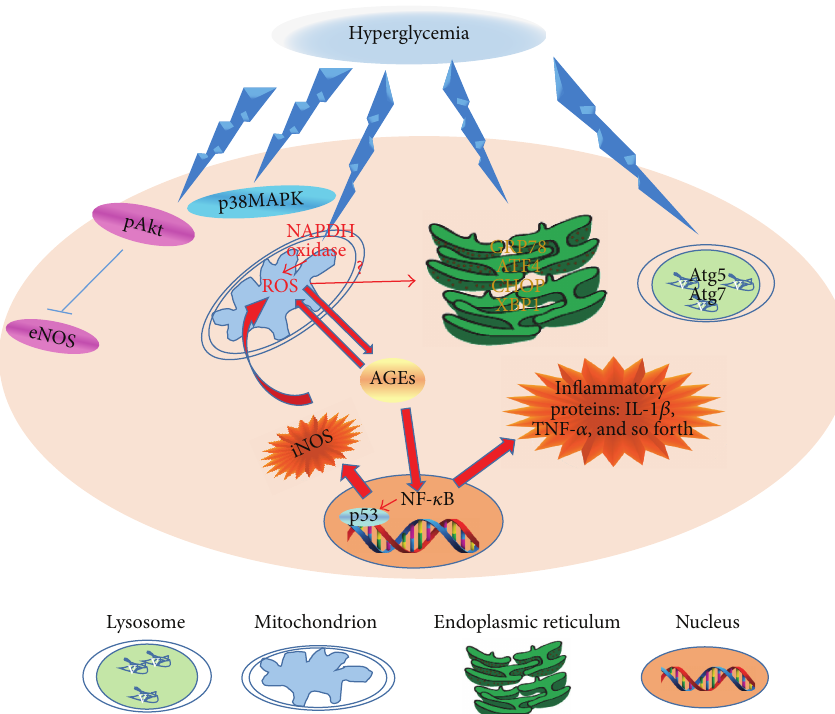
Figure 2: The detrimental effect of hyperglycemia on endothelial progenitor cells (EPCs) number and function. High level of glucose stimulates ROS production through activation of NAPDH oxidase. Increased reactive oxygen species (ROS) production triggers advanced glycatedendproducts(AGEs)formation.AGEinturnfurtherincreasesROSproductionand,inthemeantime,promotesnuclearfactor-kappa B (NF- 𝜅 B) transcription. NF- 𝜅 B is crucially involved in inflammation via transcriptional activation of its target genes such as IL-1 𝛽 and TNF- 𝛼 . In parallel, NF- 𝜅 B also activates p53 to accelerate cell senescence and iNOS that further potentiates ROS production. Except mitochondrial diabetic retinopathy ion damage,hyperglycemia induces endoplasmic reticulum (ER) stress and excessive autophagy to further facilitate EPCs death. Apart from that, hyperglycemia inhibits Akt phosphorylation and subsequently eNOS activation. It also activates p38MAPK pathway to promote cell death and senescence. Ultimately, EPCs are triggered to undergo apoptosis and become